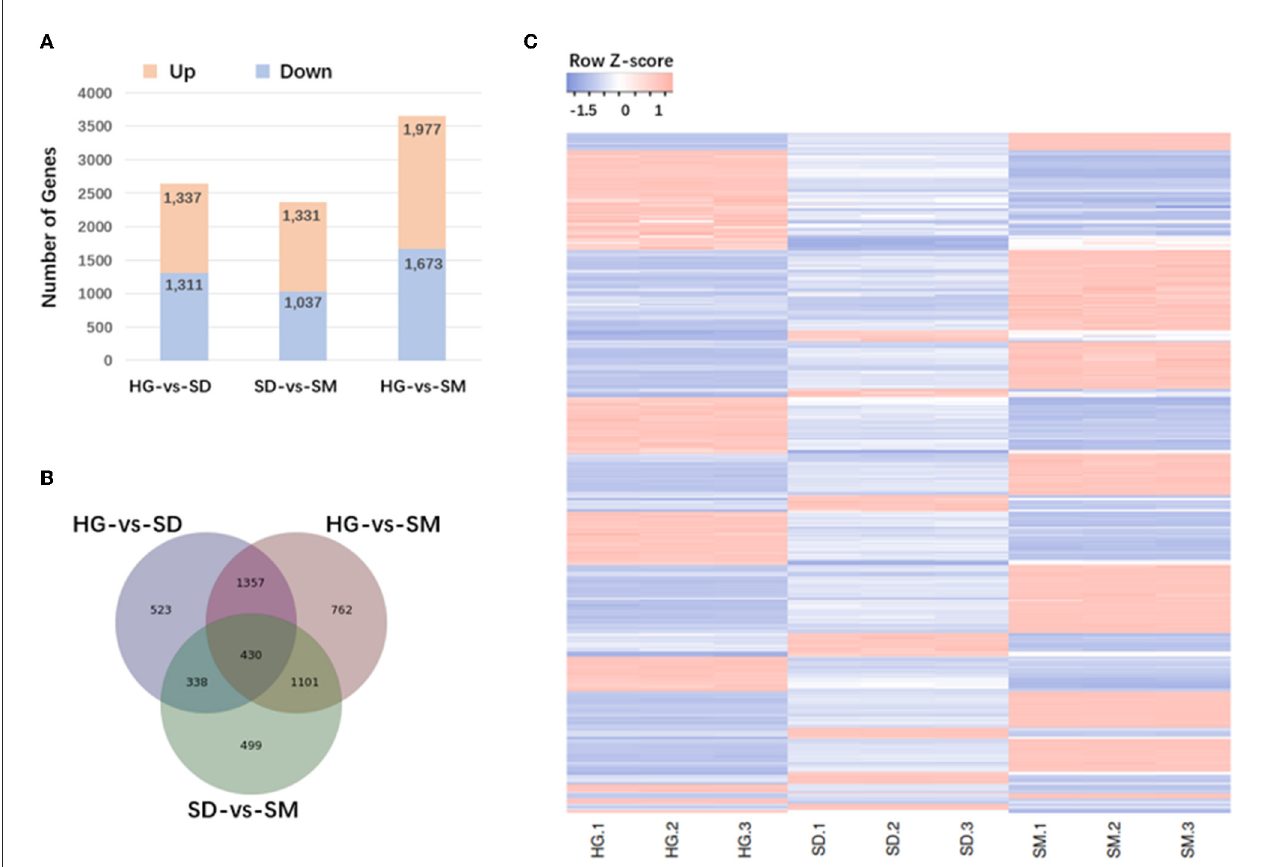
FIGURE2 Analysis of differentially expressed genes (DEGs) occurring in the three compared groups. (A) Numbers of DEGs in the different comparisons. (B) Venn diagram showing the overlapping DEGs in the three compared groups. (C) Hierarchical clustering heatmap of 430 DEGs commonly existing in the three compared